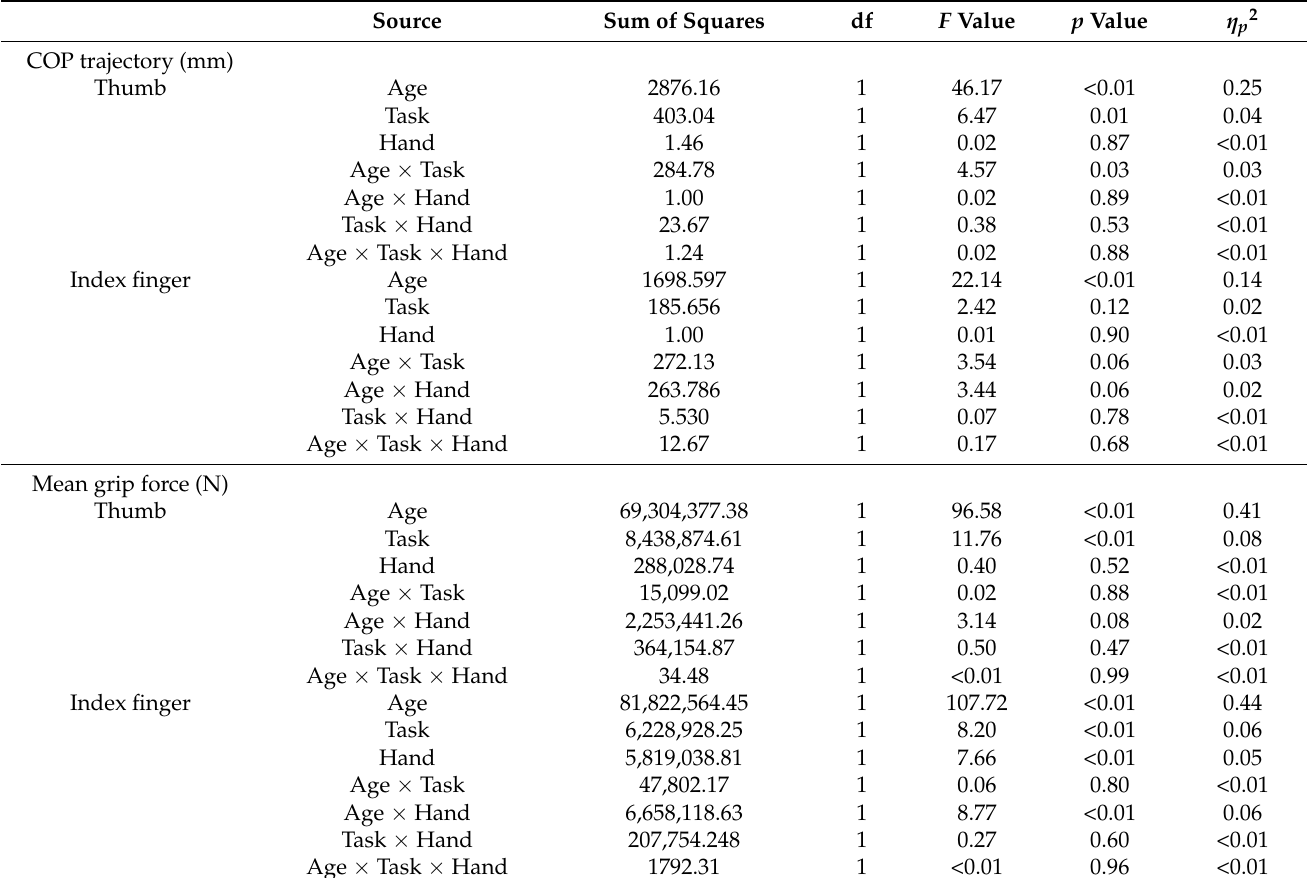
Table 3. Results of three-way ANCOVA for the effect of age, task, and hand on kinetic